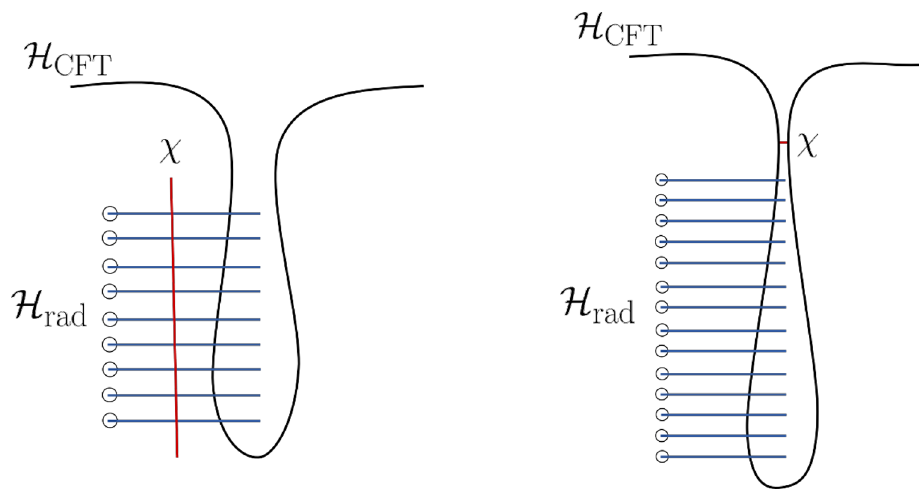
Figure 2. Schematic drawings of Cauchy slices through the black hole interior, both before the Page time (left) and after the Page time (right). The blue lines indicate entanglement between the interior of the black hole and the reservoir H rad . Before the Page time, there exist Cauchy slices where the empty surface is the surface homologous to the boundary with minimal generalised entropy. It is therefore the Ryu-Takayanagi surface (cid:31) . For illustrative purposes, we draw this surface cutting the entanglement between the interior and the reservoir. After the Page time, however, no such Cauchy slice exists. Within any Cauchy slice, there will always exist a surface, near the horizon and homologous to the boundary, with smaller generalised entropy. The Ryu-Takayanagi surface must become non-empty at the Page